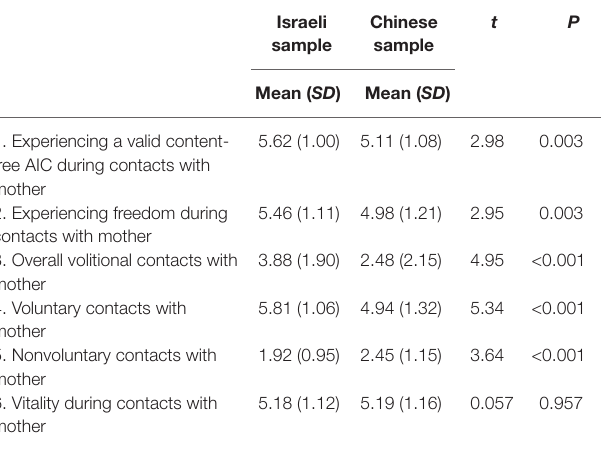
TABLE 3 | Comparisons of mean levels in the Chinese and Israeli